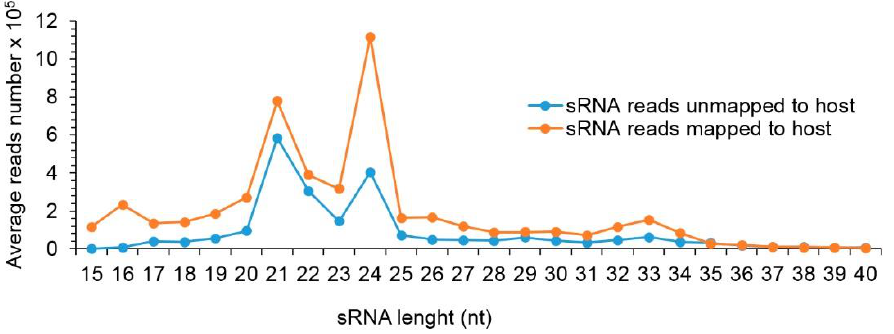
Figure 1. Small RNA size distribution of reads mapped and unmapped to host. Average number of reads of mapped and unmapped to host are shown in orange and blue lines, respectively.